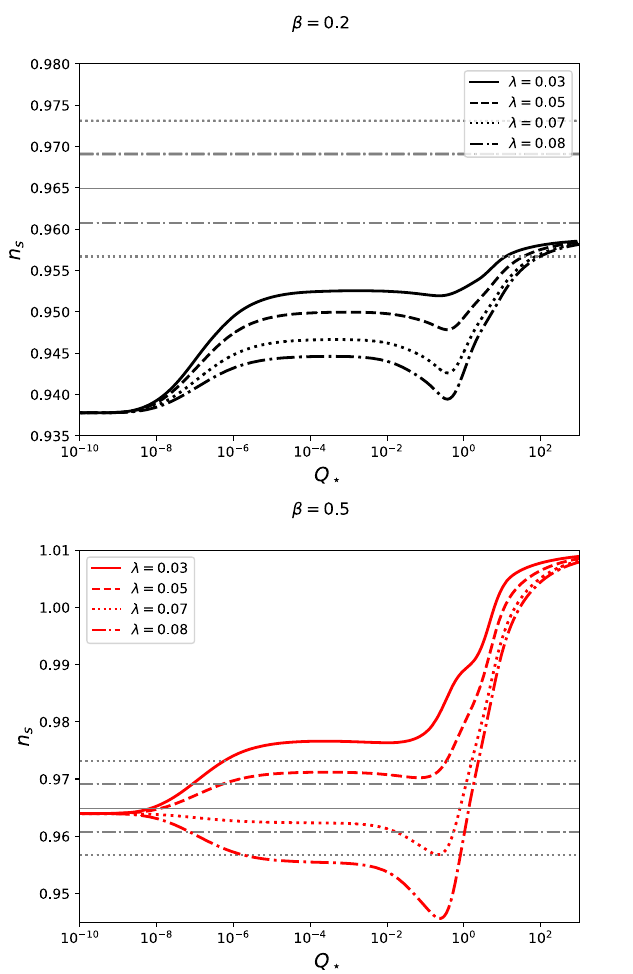
(lowerright).Thegreyhorizontallinesdenotethe68%,95%limitsof n s for Planck TT,TE,EE+lowl+lowE+lensing, n s = 0 . 9649 + 0 . 0042 + 0 . 0082 −